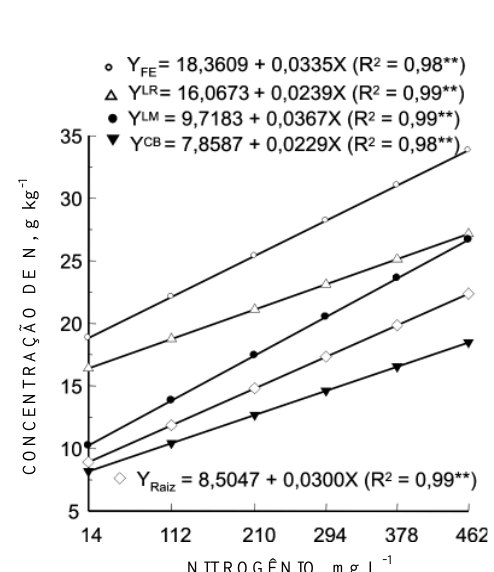
Figura 2. Concentração de N nos componentes da parte aérea (FE, LR, LM e CB), no primeiro corte do capim-Aruana, considerando as doses de N em solução nutritiva.